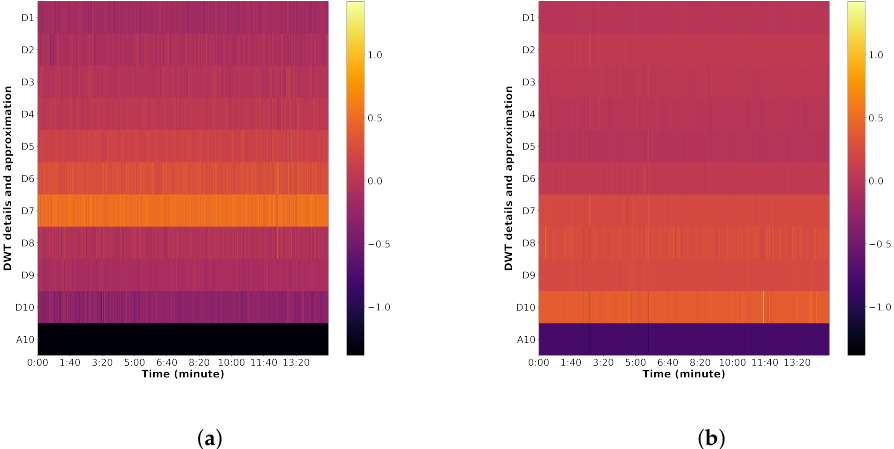
Figure 12. DWT detail and approximation component comparisons when human speech is ( a ) not present and ( b ) present near the